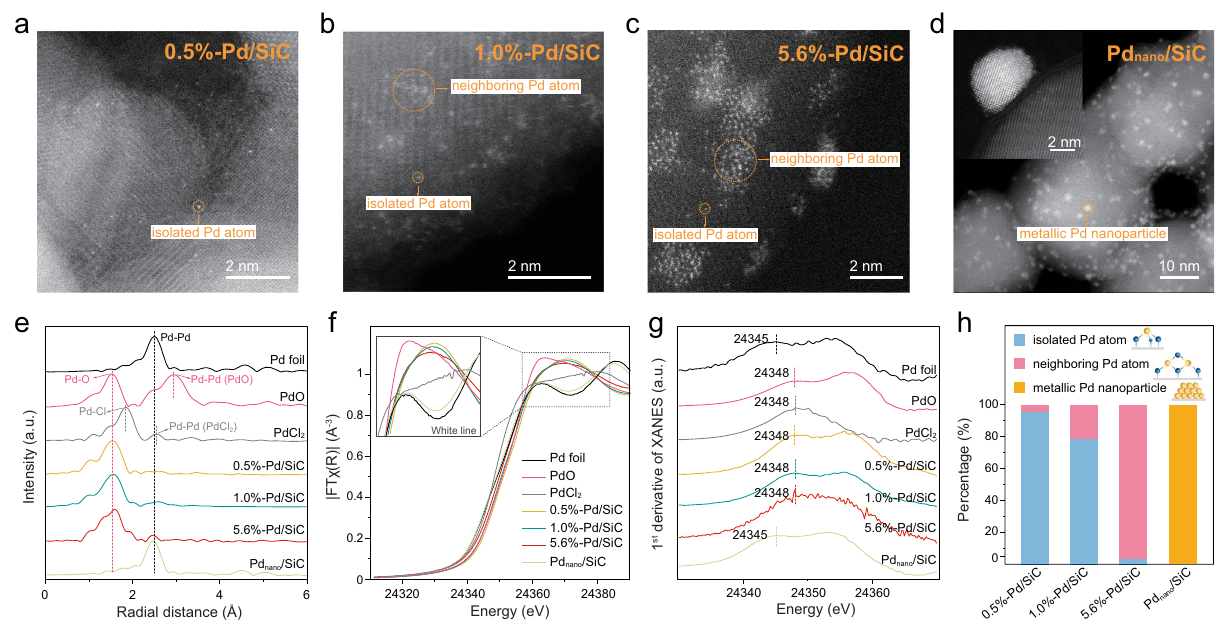
Fig. 1 Structural characterizations of Pd/SiC. a – d High-angle annular dark- fi eld scanning transmission electron microscopy (HAADF-STEM) images of 0.5%-Pd/SiC, 1.0%-Pd/SiC, 5.6%-Pd/SiC, and Pd nano /SiC (the inset shows the crystal structure of Pd nanoparticle). e Pd K -edge EXAFS spectra in R space for Pd/SiC and references. f – g Pd K -edge normalized XANES spectra and fi rst derivative curves of Pd/SiC and references. h Compositions of isolated Pd atom, neighboring Pd atom, and metallic Pd